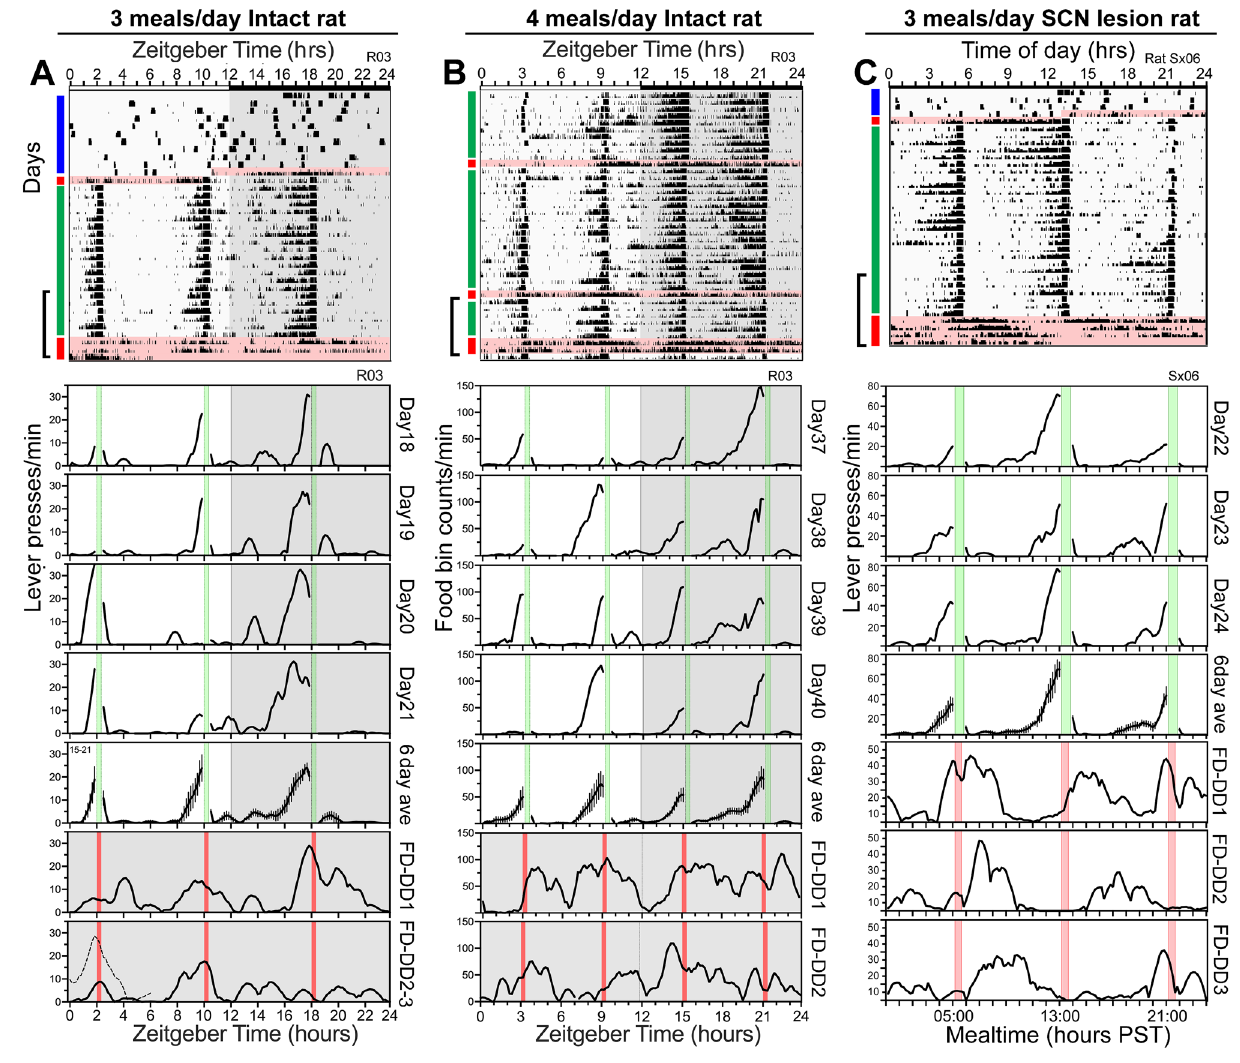
Figure 1. Rats anticipate 3 or 4 daily meals. ( A ) Upper panel: Actogram depicting lever pressing for food in a rat (R03) with food available ad-libitum for 10 days (indicated by blue vertical bar to the upper left of the actogram), followed by 1 day of total food deprivation (pink shading, red vertical bar), 21 days of restricted feeding (green vertical bar; lever pressing reinforced for 30 min starting at ZT2, 10 and 18), and 60 h of total food deprivation (pink shading, red bar). Time of day (10 min bins) is plotted left to right and consecutive days are aligned vertically. Black bars represent time bins with activity. The height of each bar represents relative amount of activity (quintiles). Lower panels: Waveforms of lever pressing for rat R03 on days 18–21 of the 3-meal schedule, and during 60 h of food deprivation in constant dark (FD-DD). Mealtimes are denoted by green vertical bars during scheduled feeding (lever presses yield 20 mg food pellets) and by red vertical bars when lever presses were not reinforced (FD-DD). The fifth panel in the column is the average of the last 6 days of scheduled feeding prior to total food deprivation. Data were smoothed using a 40-min running average. ( B ) Upper panel: Actogram of operant nose-poking for food in rat R03 with 4 daily 15–30 min feeding opportunities, at ZT3, 9, 15, and 21. Lower panels: Waveforms of operant nose-poking for rat R03 on days 37–40 of the 4-meal schedule, and during the 2 days of total food deprivation (FD-DD). The fifth panel is the average of the last 6 days of scheduled feeding prior to the 2-day food deprivation. ( C ) Upper panel: Actogram of lever pressing in a representative SCN-ablated rat (Sx06), fed at 05:00 h, 13:00 h, and 21:00 h local time each day in constant dim light. Lower panels: Waveforms of lever pressing on days 22–24 of the 3-meal schedule, and during the 3 days of total food deprivation. Panel 4 is the average of the 6 days of scheduled mealtimes prior to total food